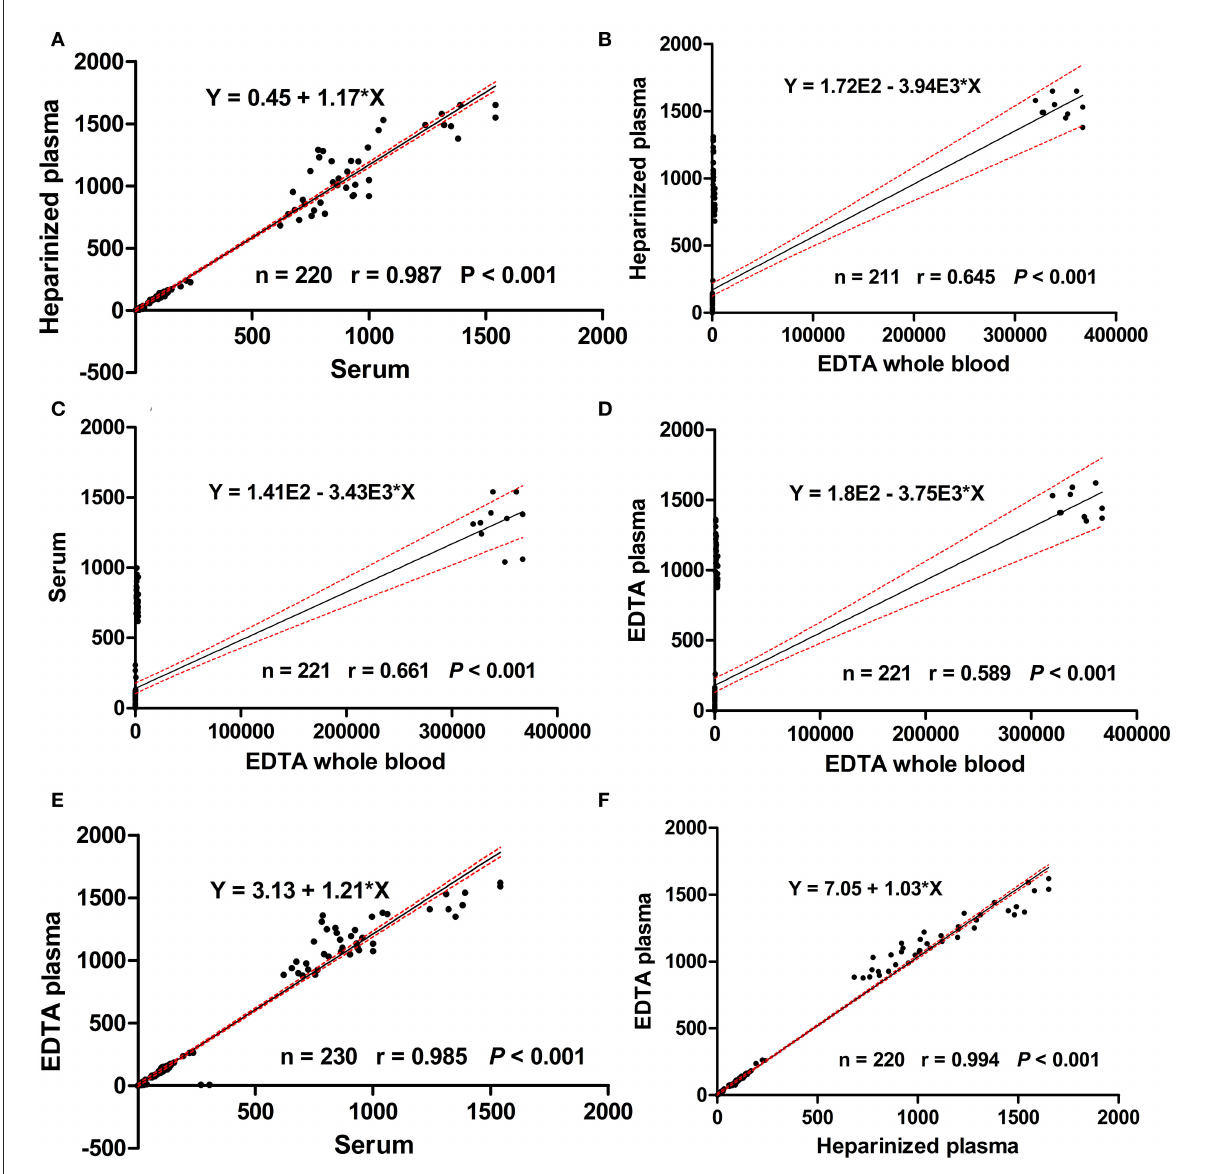
FIGURE2 Scatter plots for the regression analysis of mineral concentrations in heparinized plasma vs. serum (A) , heparinized plasma vs EDTA whole blood (B) , serum vs ETDA whole blood (C) , EDTA plasma vs EDTA whole blood (D) , EDTA plasma vs serum (E) , and EDTA plasma vs heparinized plasma (F) . Black lines represent the regression lines, the 2 dashed red lines represent the 95% confidence